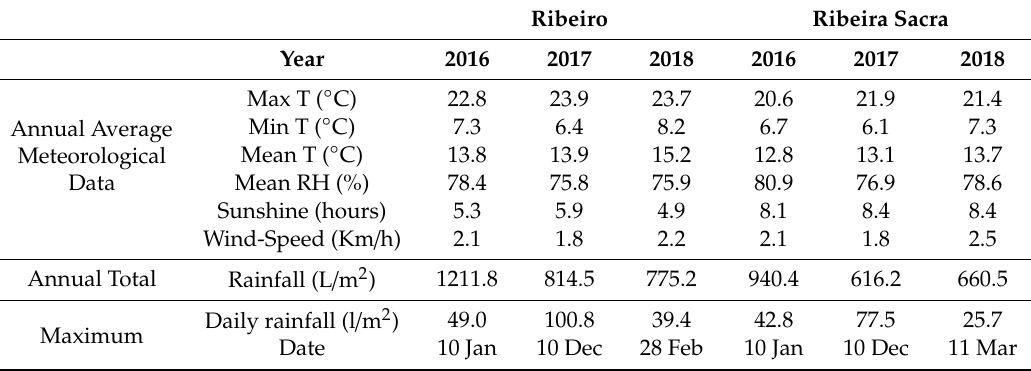
Table 1. Meteorological parameters, maximum temperature, minimum temperature, average temperature, average relative humidity, sunshine, wind speed and rainfall, in the study area (2016– 2018).